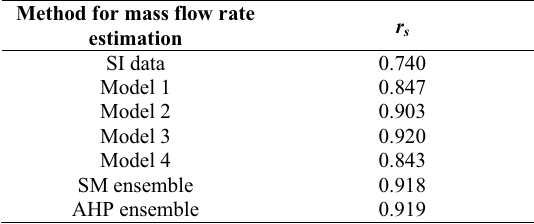
Fig. 8. Comparison of the health indicator obtained using the allocated values of the mass flow rates and those estimated by the AHP